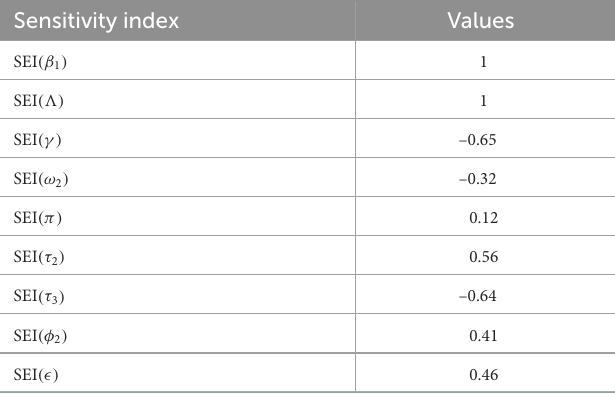
FIGURE2 The complete model solutions behavior if R cs 0 < 1 at β 1 = 0.3 and β 2 = 0.08.